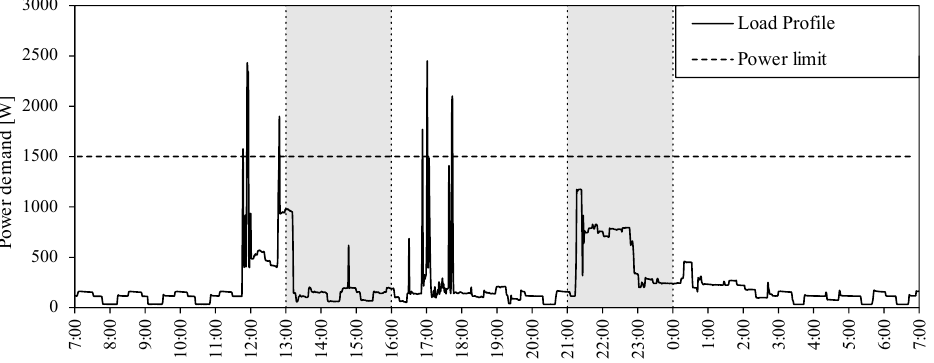
Figure 5. Exemplary load profile for one of the grid bottleneck CtAs. In this case, for the time slots from 13:00 to 16:00 and 21:00 to 24:00 a power limit of 1.5 kW was suggested. The CtA was paired with a social incentive (reduce the chances of a power outage in your community by staying below the proposed power